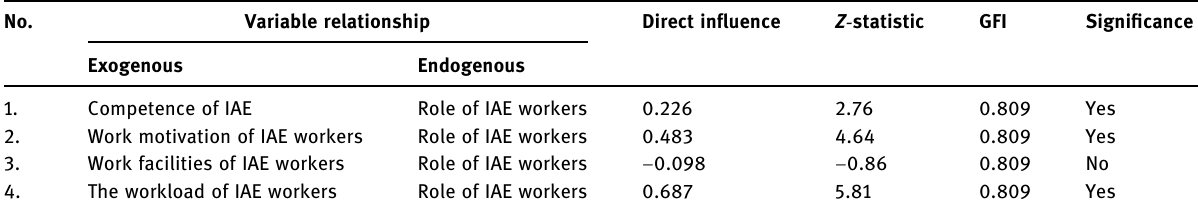
Table 5: Coe ffi cients and Z - statistic the e ff ect of exogenous variables on endogenous variables Y 1